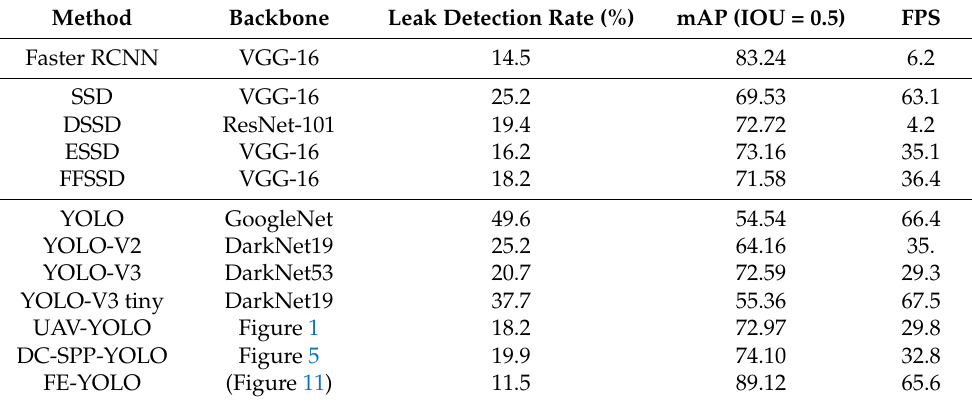
Table 11. The comparative results with the VIDEA dataset.